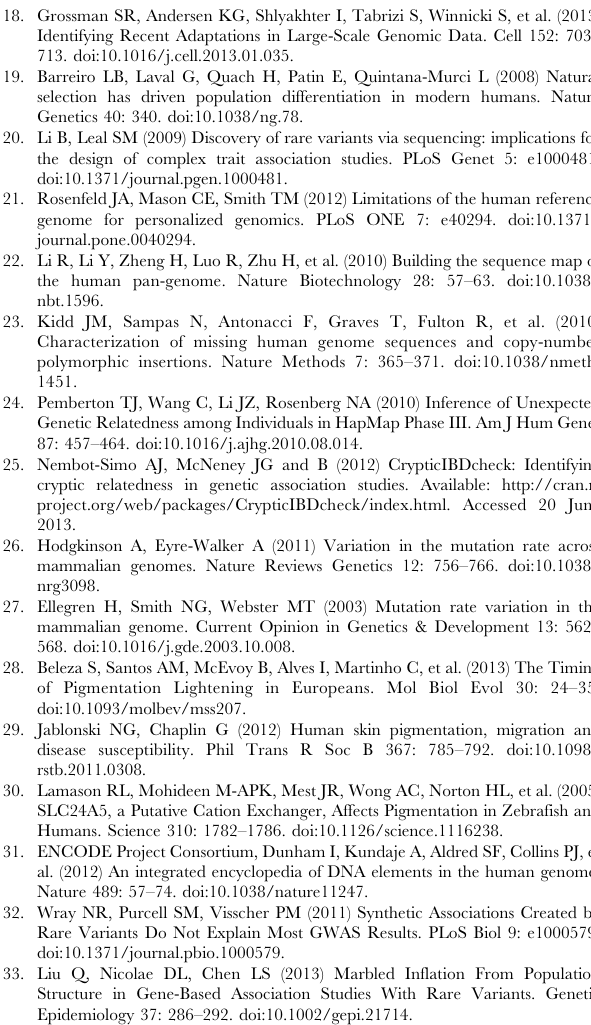
each population sequenced on ABI solid, Illumina, LS454 or Illumina and LS454. Table S2 Reviewing regions of interest found in Barreiro study. Genes identified in Barreiro study with an F ST value . 0.65 that were also found in the regions identified by Pritchard (J.P.),